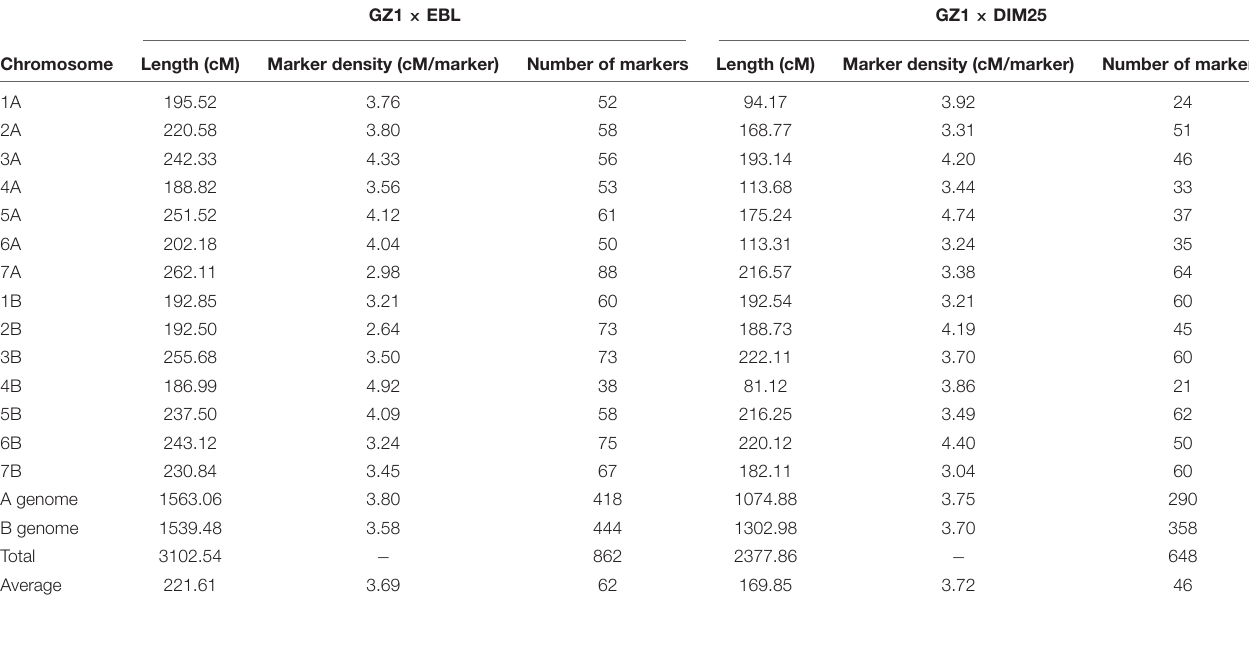
TABLE 2 | GZ1 × EBL and GZ1 × DIM25 skeleton linkage maps.